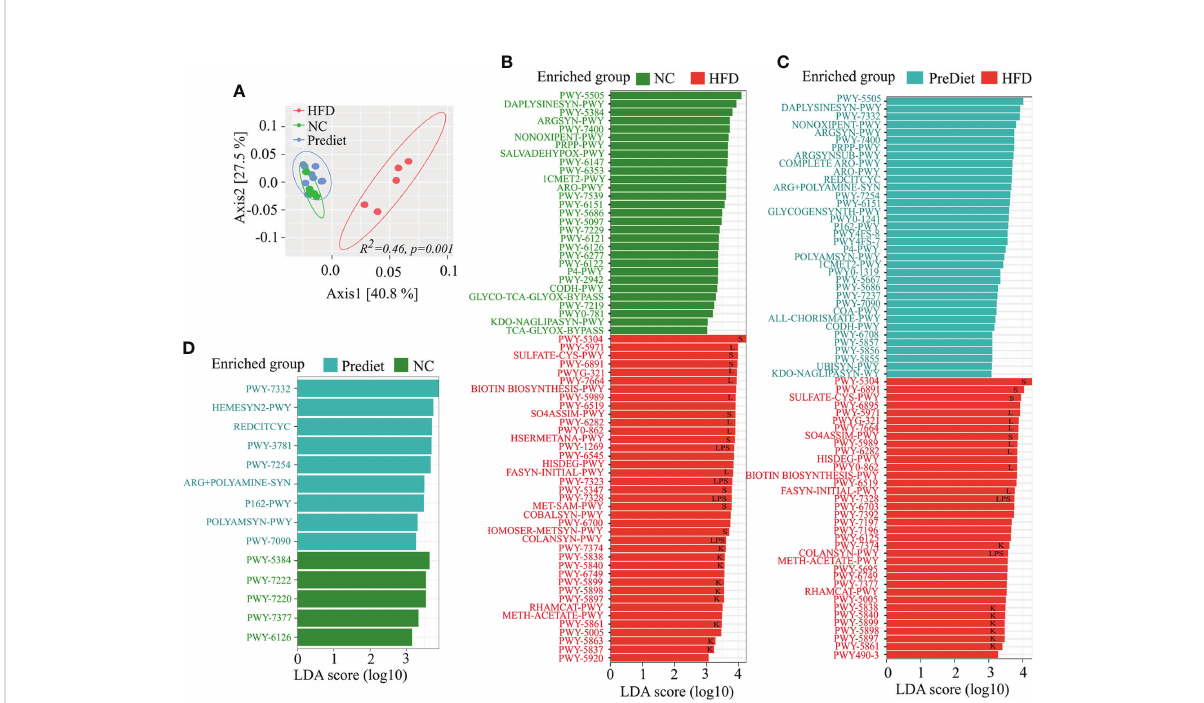
FIGURE 4 Functional investigation of the microbial communities in HLA-DR3 Transgenic Mice Fed with HFD and NC. (A) PCoA representing differentially clustering patterns of HFD, NC and prediet communities using Bray Curtis dissimilarity metrics. Lefse analysis showing functional pathways signi fi cantly enriched in (B) HFD compared to NC, (C) HFD compared to prediet conditions and, (D) NC and prediet conditions. Lefse analysis was carried out with lda_cutoff of 3 and wilcoxon_cutoff of 0.01, and kw_cutoff of 0.01 respectively with other parameters remaining